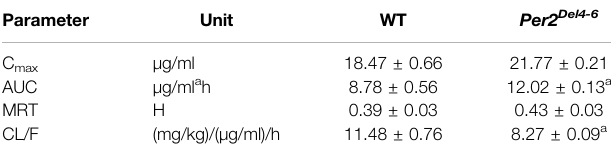
TABLE 2 | Pharmacokinetic parameters for CPA (100 mg/kg, i.p.) after drug administration to Per2 Del4-6 and wild-type (WT) mice. Parameter